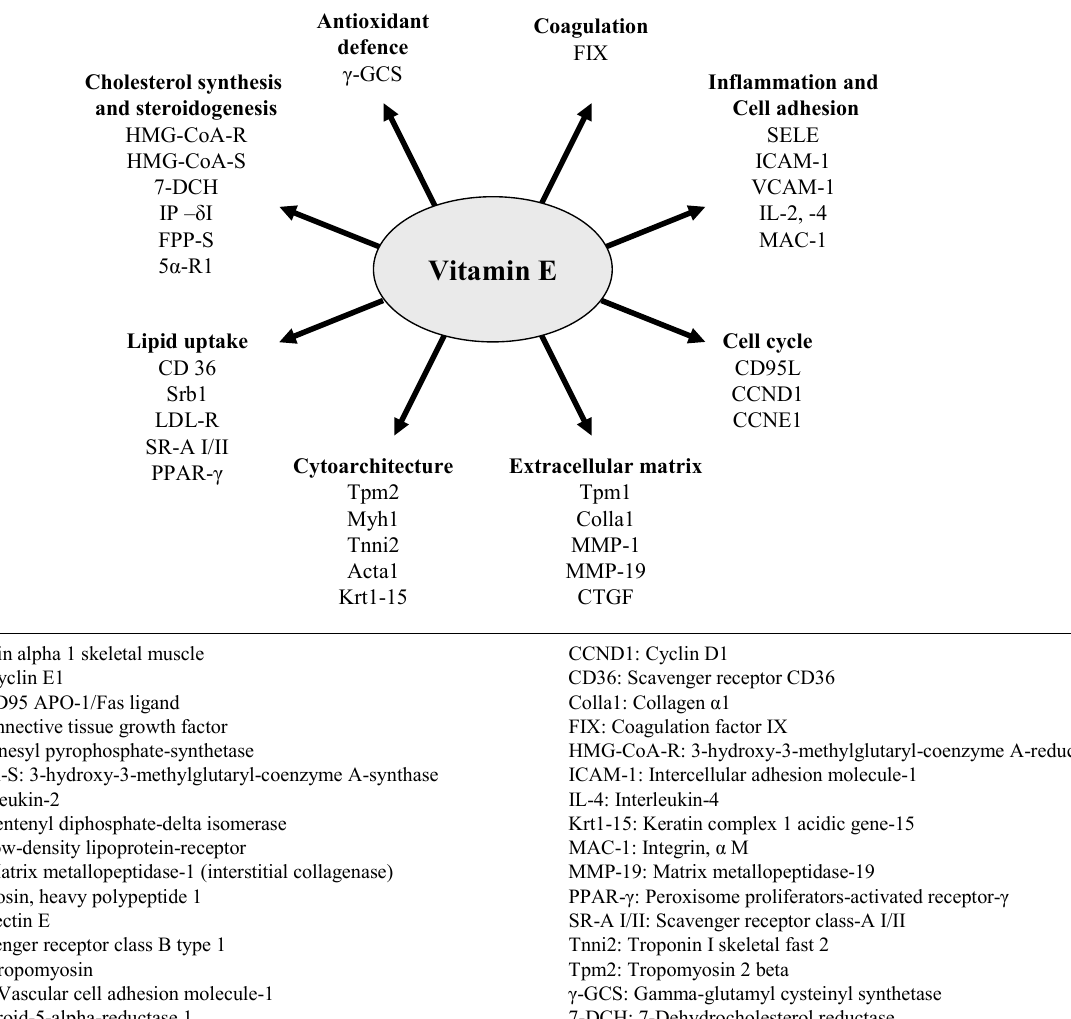
Figure 5. Transcriptional regulation of vitamin E target